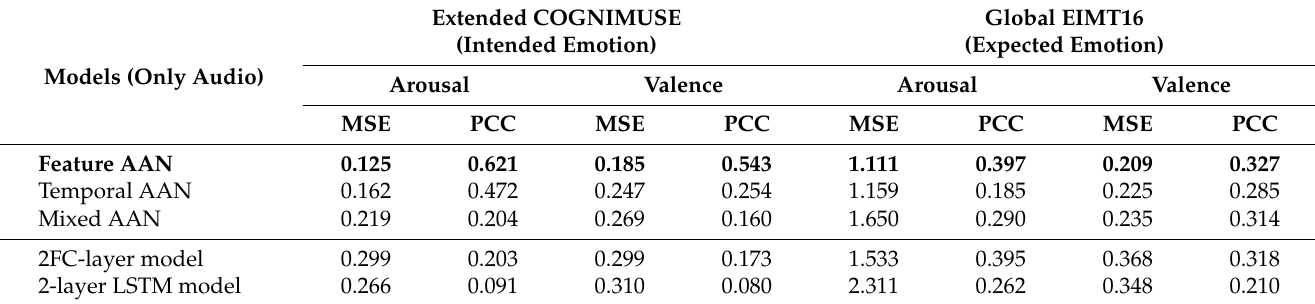
Table 2. The performance of the proposed models using only audio